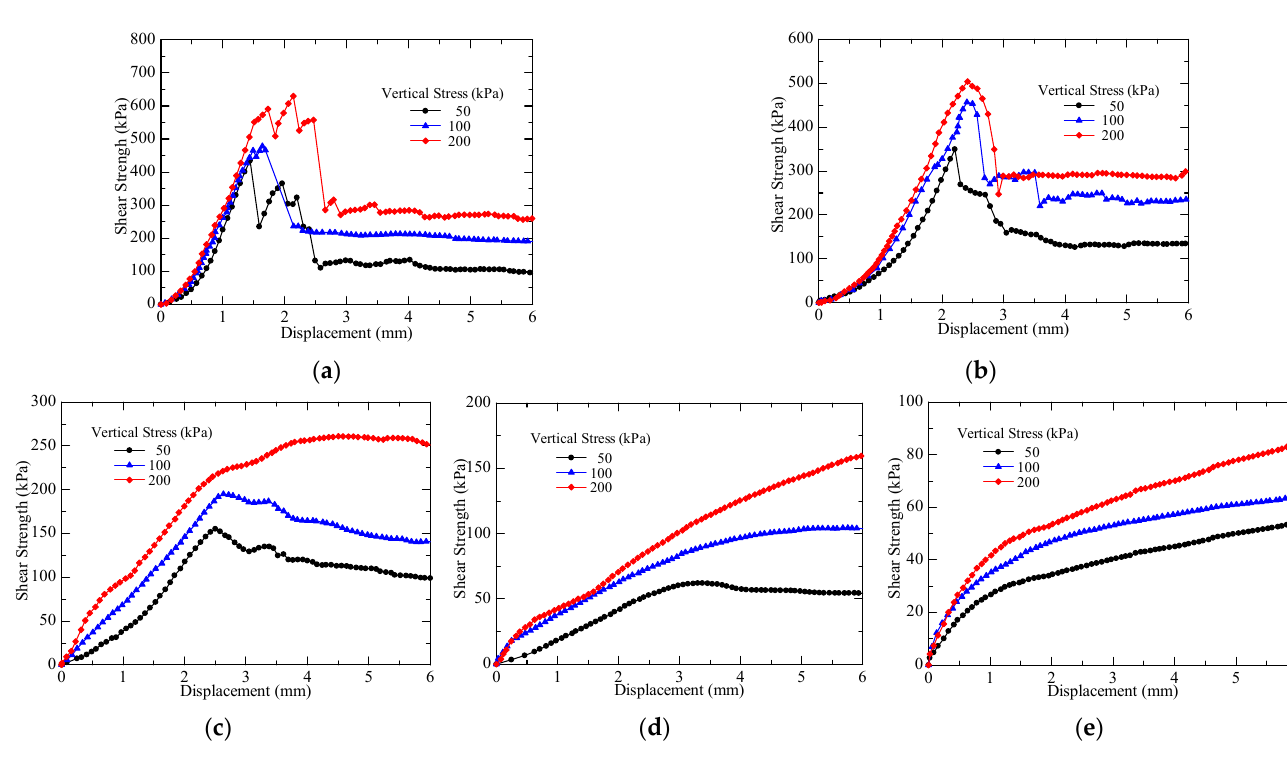
Figure 15. Shear strength of the silt samples with different water contents ( m bp / m s = 0%): ( a ) w = 2%; ( b ) w = 4%; ( c ) w = 8%; ( d ) w = 16%; ( e ) w = 22%.